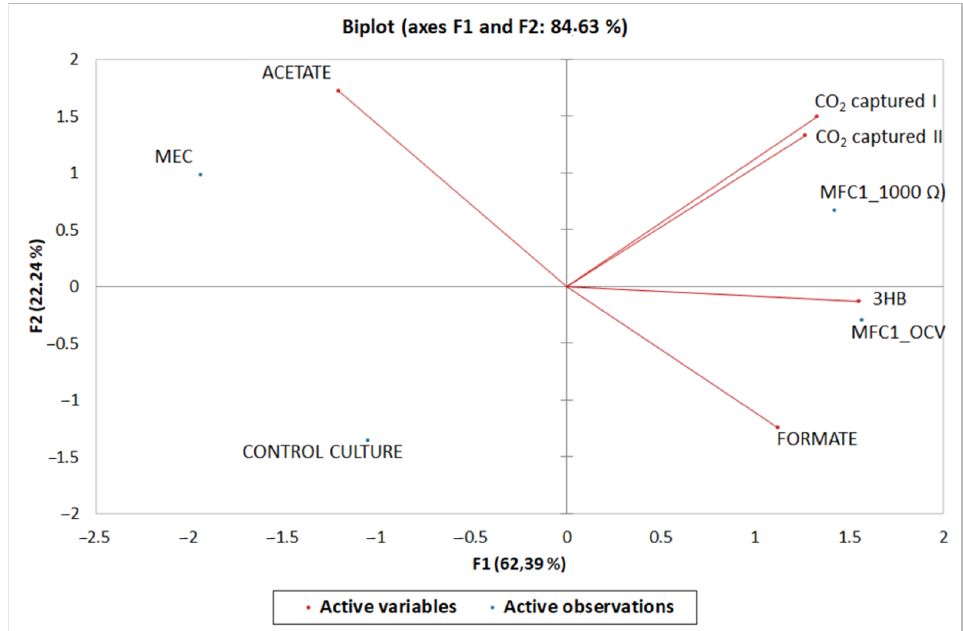
Figure 5. PCA diagram (5% significance level). 3HB = 3-D-Hydroxybutirate; CO 2 captured I and CO2 captured II are the mol of CO 2 captured after 15 min and 6 h of gas sparging.